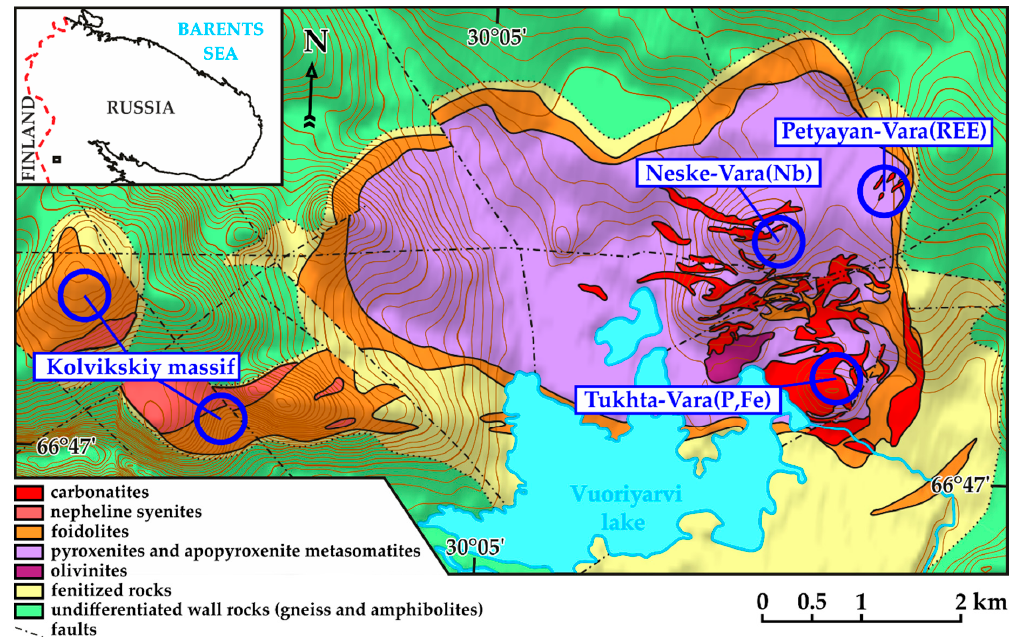
Figure 1. The geological setting and structure of the Vuoriyarvi alkaline-ultrabasic carbonatite complex simplified from [83]. Blue circles indicate the positions of the Tukhta-Vara, Neske-Vara, and Petyayan-Vara carbonatite fields and the Kolvikskiy agpaitic nepheline-syenite massif-satellite.